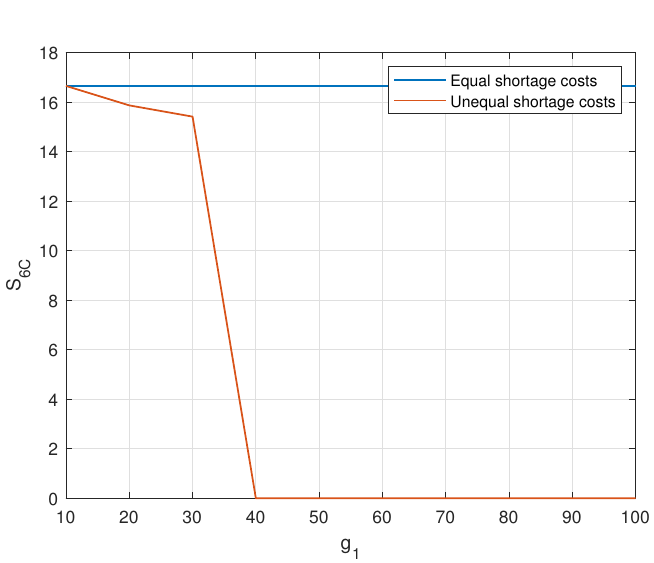
Figure 3. Effect of g 1 on S 3 C .